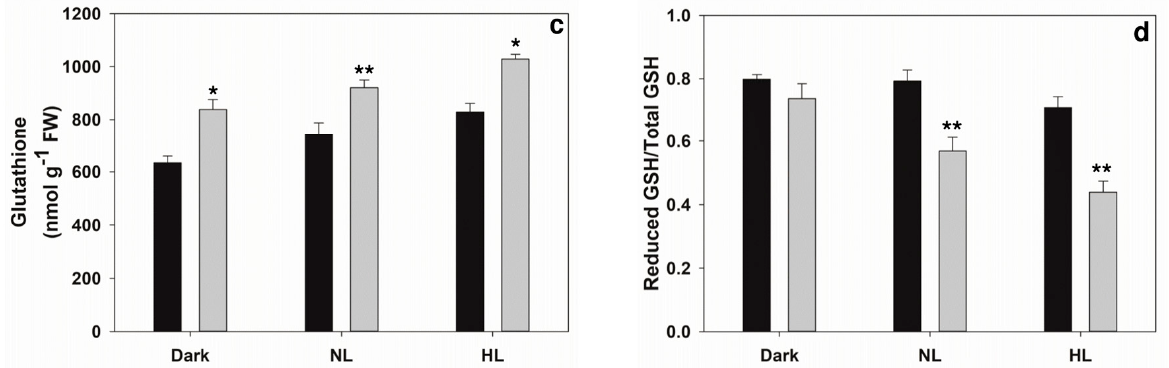
Figure 2. The levels of antioxidants: ascorbate ( a ) and glutathione ( c ) and their redox ratios ( b , d ) on treatment with light and/or 10 µM MD. Each data point is the average of three replicates, and error bars represent ±SE. Asterisks indicate the significance of MD effect compared to the respective control. * p < 0.05; ** p < 0.001.